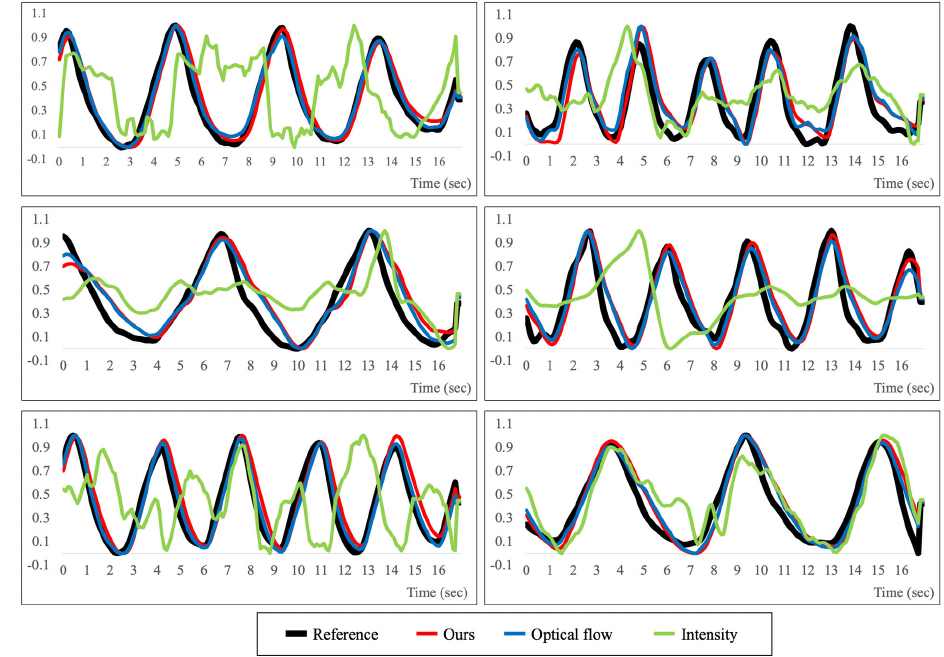
Figure 12. Comparison analysis of reference and inference respiration signal.